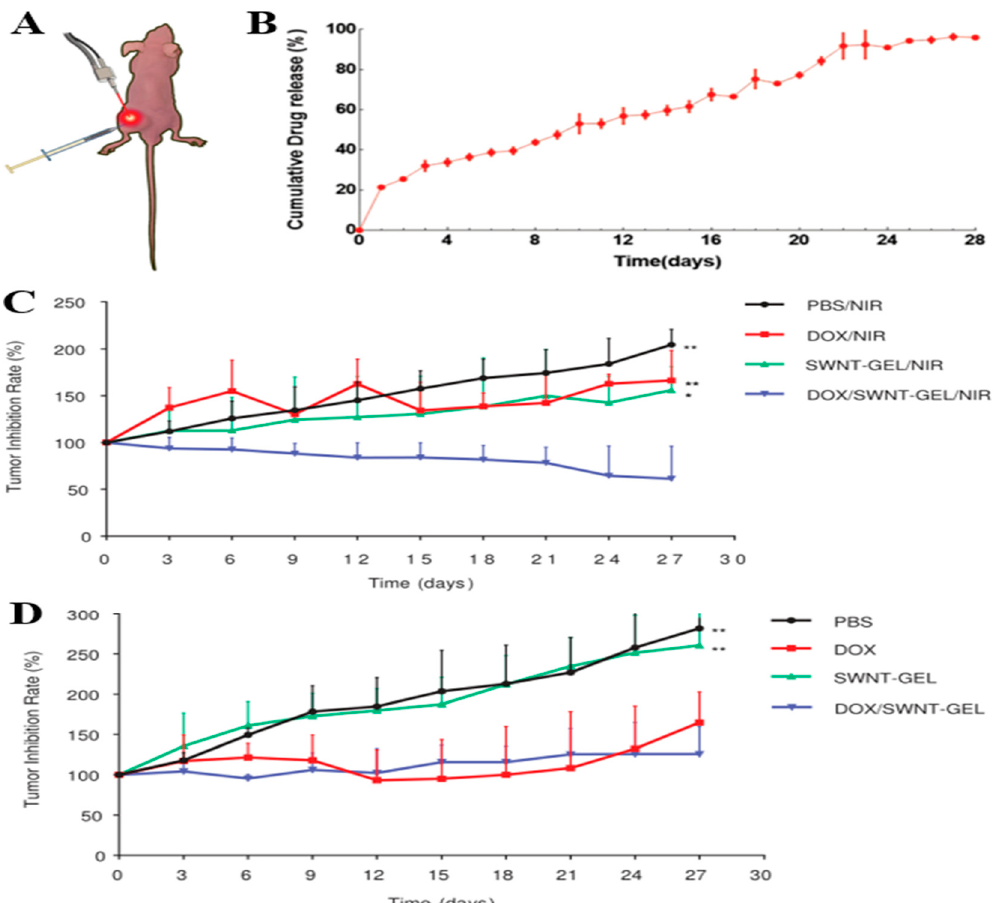
Figure 2. ( A ) The xenograft tumor model was established by subcutaneous injection of BGC-823 gastric cancer cells in mice. DOX/SWNT-GEL was injected into the tumor, and then the mice received NIR laser irradiation at the tumor site; ( B ) DOX release curve of SWNT-GEL in PBS for 28 days at a constant temperature of 43 °C; ( C ) tumor growth rate of mice treated with different methods and NIR radiation; ( D ) tumor growth rate of mice with different treatments without NIR radiation. Data was presented as mean ± SD (* indicates p < 0.05 and ** denotes p ≤ 0.01, compared with DOX/SWNT-GEL/NIR or DOX/SWNT-GEL group). Reproduced with permission from ref. [78] Copyright (2015). Wiley-VCH Verlag.